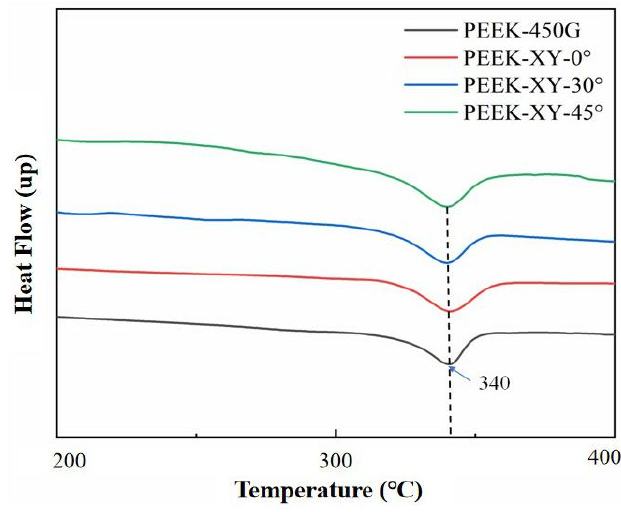
Figure 4. DSC thermograms of PEEK 450G and FDM printed PEEK parts.